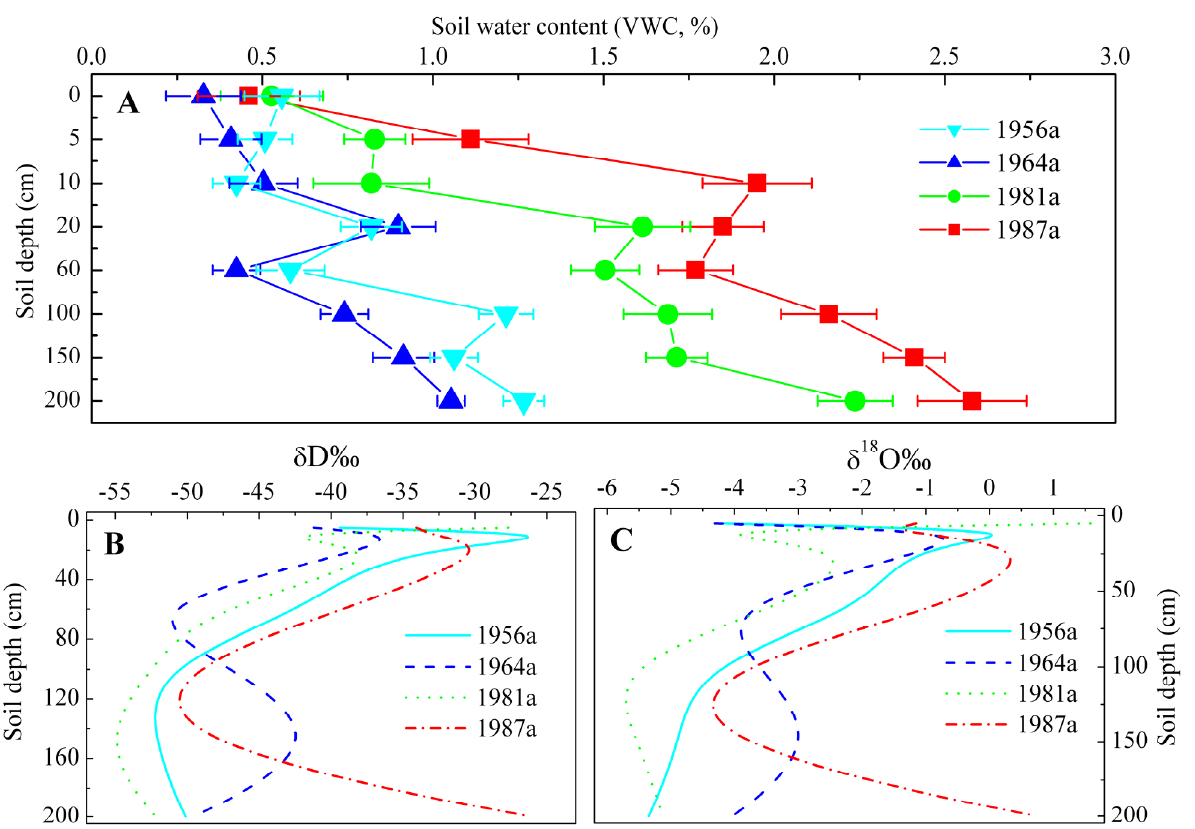
Figure 2. Profiles of soil water content ( A ) and average soil water isotopic concentration δ D ( B ) and δ 18 O ( C ) at different revegetated sites ( n =